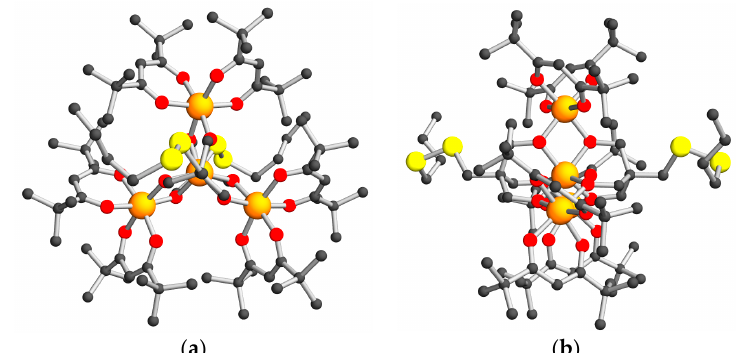
Figure 3. Molecular structure of 3 viewed along ( a ) and perpendicular to ( b ) the idealized three-fold axis. Same color code as in Figure 1. Minority components of disordered moieties and hydrogen atoms have been omitted.